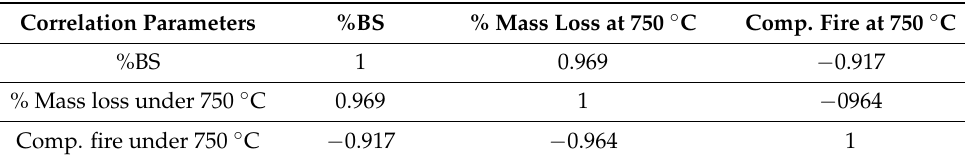
Table 4. The correlation coefficient between %BS, compressive strength, % mass loss at 750 ◦ C fire exposure at 180 days for group Z.